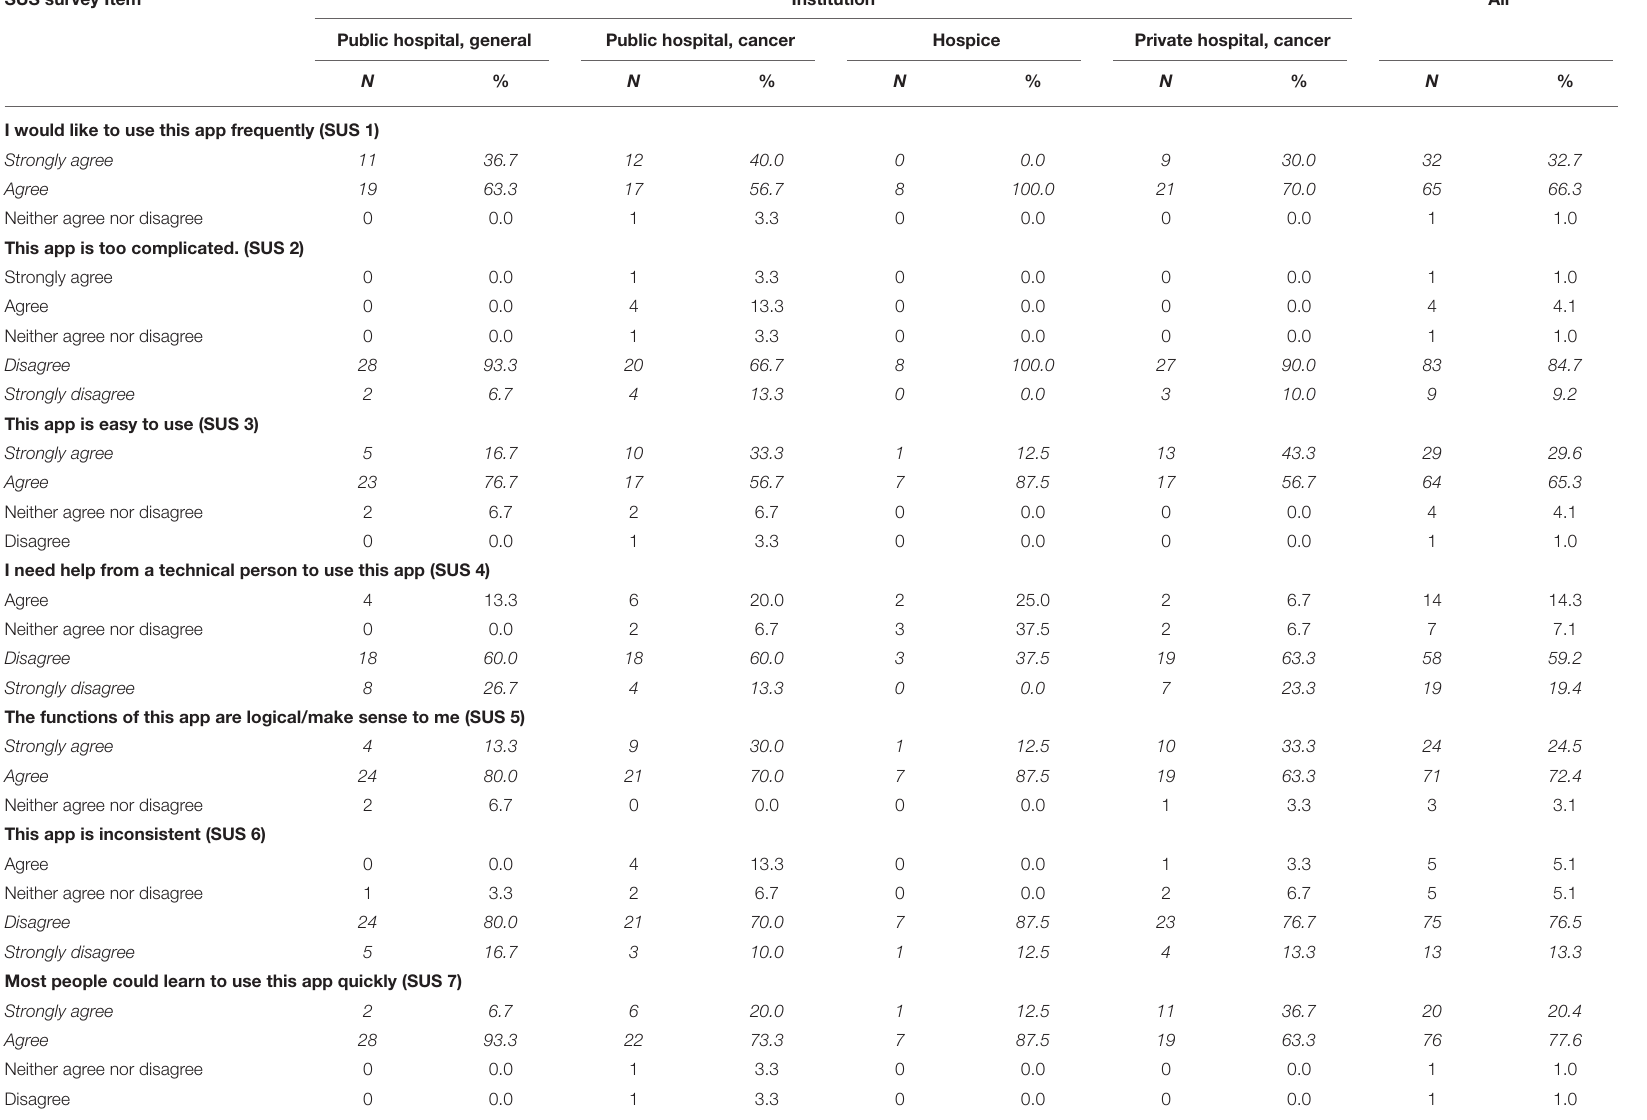
TABLE 5 | SUS survey responses, by institution. SUS survey